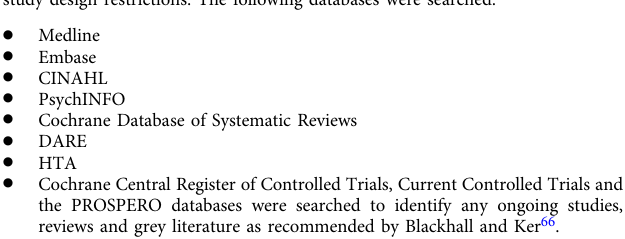
Table 3). Data extracted included: (i) participant group studied and where